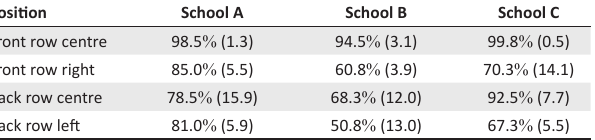
TABLE 3: Digit triplet test scores for students with normal hearing in different positions in the classrooms at the different schools. The results are the mean value of four children in each position, with standard deviations in brackets.